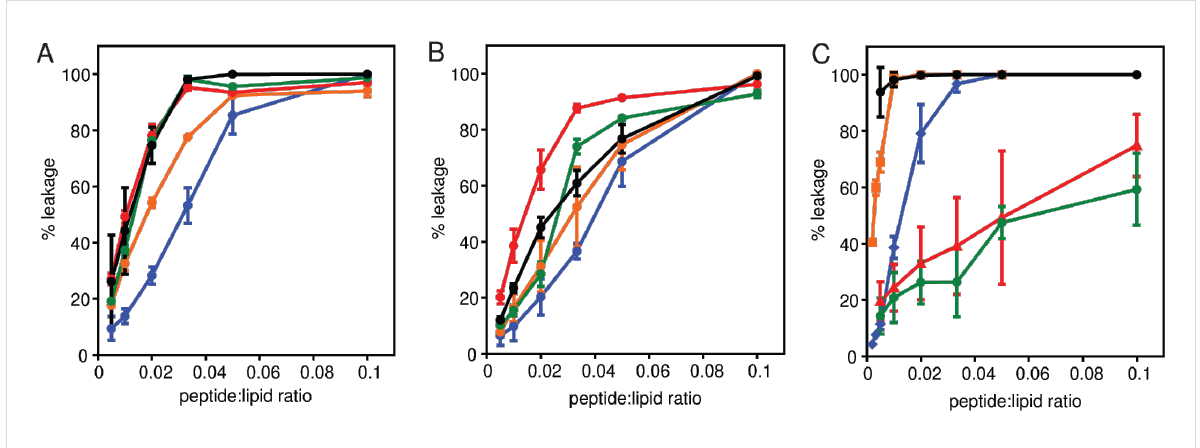
Figure 4: Percent calcein leakage induced by the gp41 derivatives. Gp41w (blue), gp41w-4R (orange), gp41w-KA (red) and gp41w-FKA (green) were added to calcein encapsulated LUVs composed of (A) ePC:ePG, (B) ePE:ePG and (C) ePC:ePE at different peptide:lipid ratios. Melittin (black),